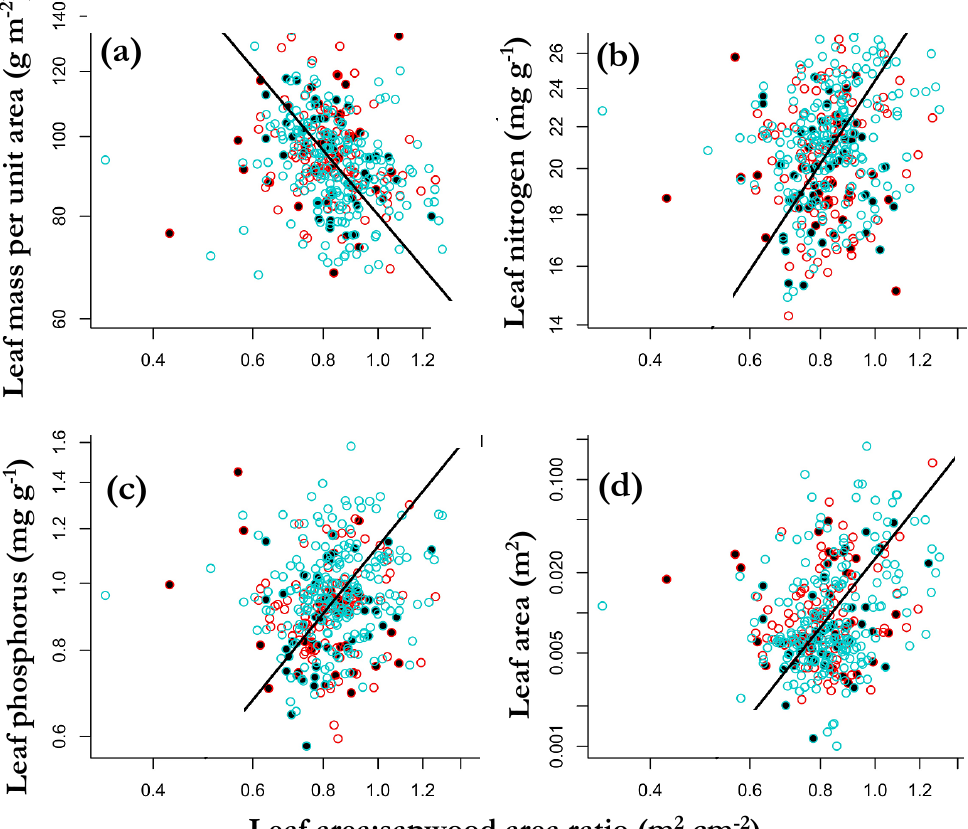
Fig. 5. Standard Major Axis (SMA) regression lines between the derived species components of leaf area/sapwood area ratio ( 8 LS ) and those for mass per unit area M A , foliar [N], foliar [P] and average leaf size for the same species.Red open circles indicate species found on low fertility sites and the blue open circles indicate species found on high fertility sites. Species found on both soil fertility groups are indicated with closed circles (see text for details). Solid lines show the SMA model fit which did not depend on soil fertility.